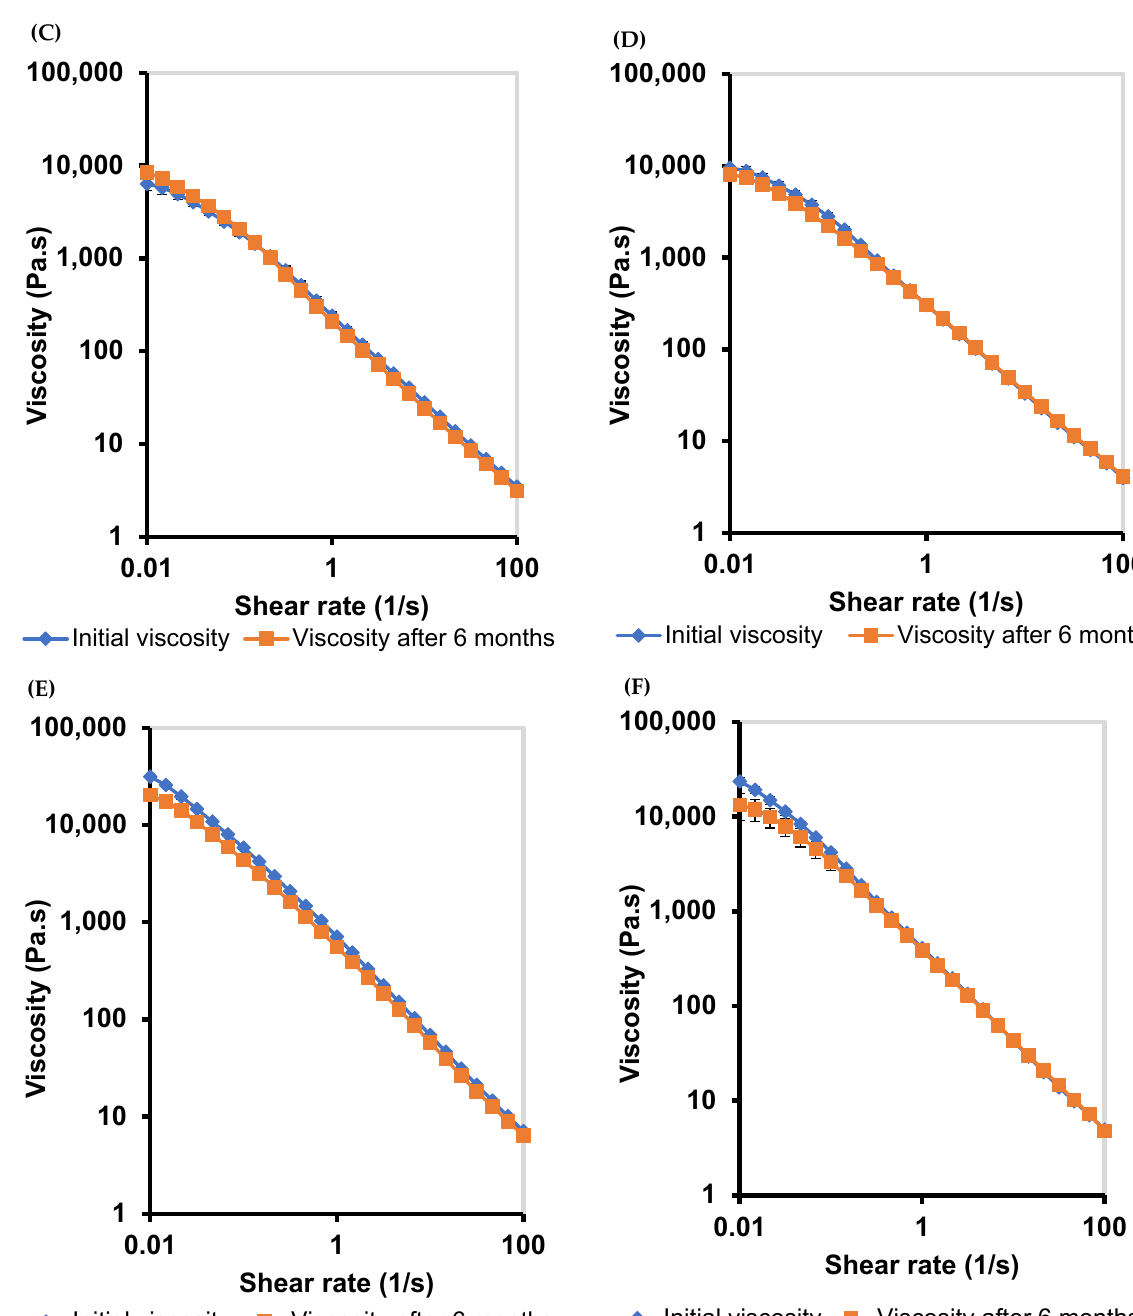
Figure 11. Viscosity curves of: ( A ) M2, ( B ) M3, ( C ) M4, ( D ) M5, ( E ) M6, and ( F ) M7 microgels after six months of storage at room temperature.